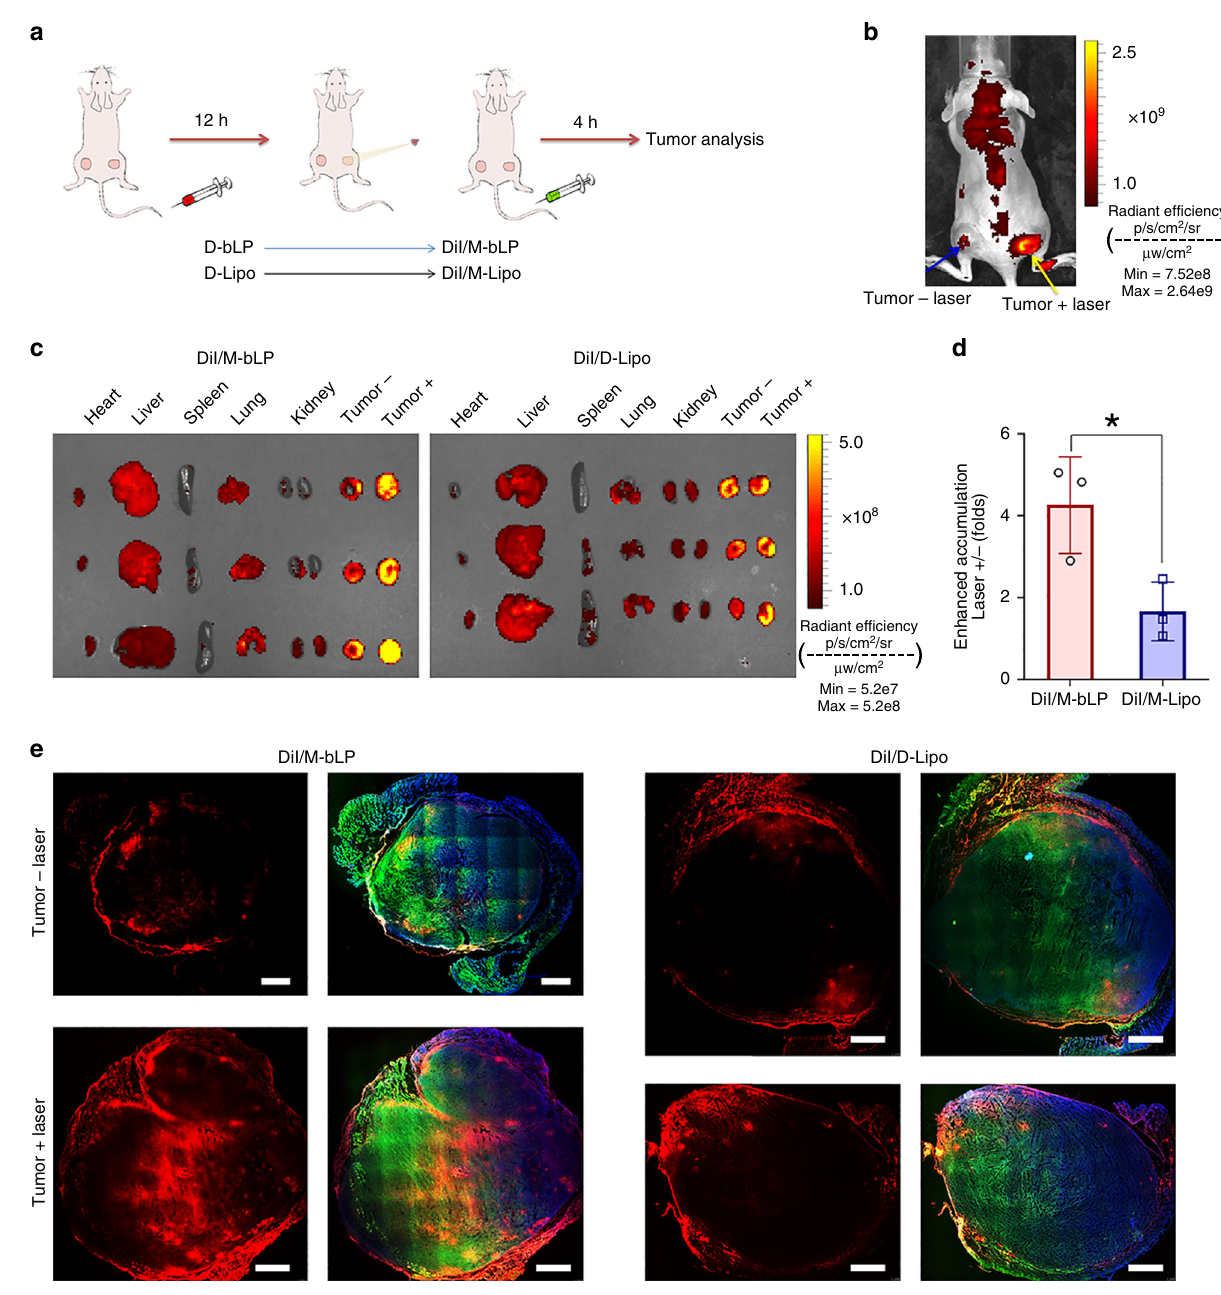
Fig. 5 Impact of D-bLP-mediated TSM remodeling on tumor accumulation and penetration of second DiI/M-bLP. a Schematic illustration of the treatments in the two-tumor model, in which one tumor was irradiated at 12 h after injection D-bLP or D-Lipo, and the other one was not irradiated as a control, then followed with the second injection of DiI/M-bLP or DiI/M-Lipo via tail vein. The measurements were performed at 4 -h post injection. b Distribution of second DiI/M-bLP in a two-tumor model after D-bLP-mediated TSM remodeling. c The ex vivo imaging of DiI/M-bLP and DiI/M-Lipo in major organs from a two-tumor model after TSM remodeling ( n = 3). d The enhanced accumulation of second DiI/M-bLP or DiI/M-Lipo in tumor with laser irradiation ( n = 3). The data are means ± SD, * p < 0.05 (two-tailed Student ’ s t test). e Penetration of DiI/M-bLP and DiI/M-Lipo in tumor mass with and without laser irradiation, wherein the actin and nuclei were, respectively, stained with phalloidin-FITC and DAPI for visualization under LCSM, scale bar, 1.0